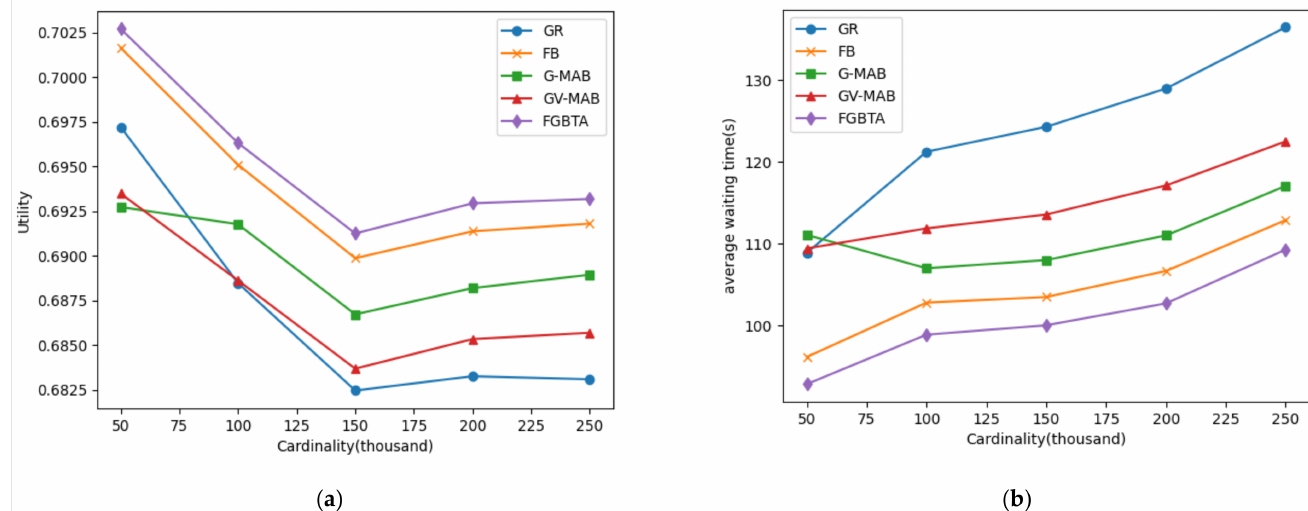
Figure 8. ( a ) Comparison of total utility score; ( b ) comparison of average wait time for tasks. In Figure 8b, the horizontal axis represents the change in cardinality, and the vertical axis represents the average waiting time. In the comparison chart of the average waiting time of tasks in Figure 8b, the average waiting time of tasks calculated by FGBTA algorithm is the shortest, followed by FB algorithm. The greedy algorithm (GR) has the longest average waiting time, because the real-time batch algorithm needs to match immediately, and the obtained information is limited, thus it cannot delay the allocation to wait for a more suitable matching object. As the waiting time of the task is composed of the waiting time for allocation and the pick-up time of crowdsourcing workers, we can see more details from Figure 9a,b.